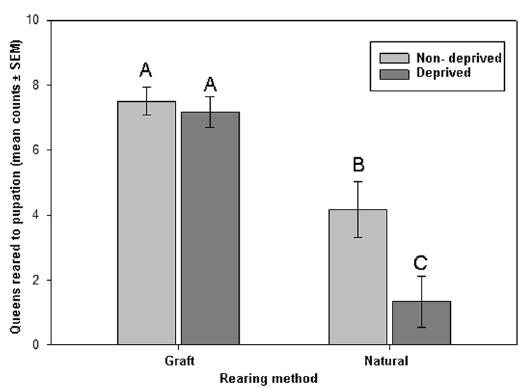
Figure 3. Figure depicts the effects of queen rearing method on the acceptance of deprived (dark grey) and non-deprived (light grey) young larvae for queen rearing. A significantly higher number of larvae were selected for queen rearing (to pupation) from the non-deprived group compared to the deprived group (p < 0.01) when workers selected larvae in the natural selection method. No such significant difference between the groups were observed in the artificial selection method. For all variables with the same letter (A,B or C), the difference between the means is not statistically significant. The data was pooled for all the larvae in each of the deprived and non-deprived groups (N = 2). Bars indicate